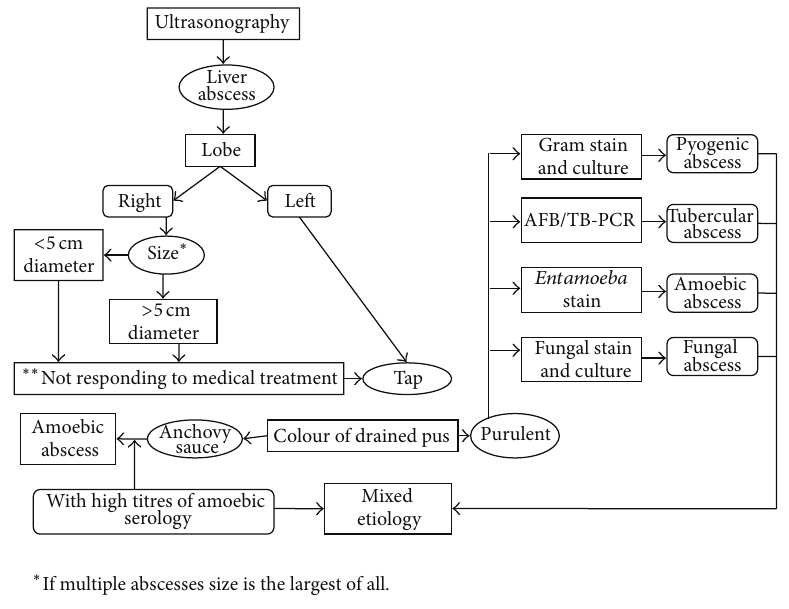
Figure 1: Flowchart depicting protocol followed for percutaneous ultrasound guided drainage of liver abscess and its appropriate processing [7, 8].